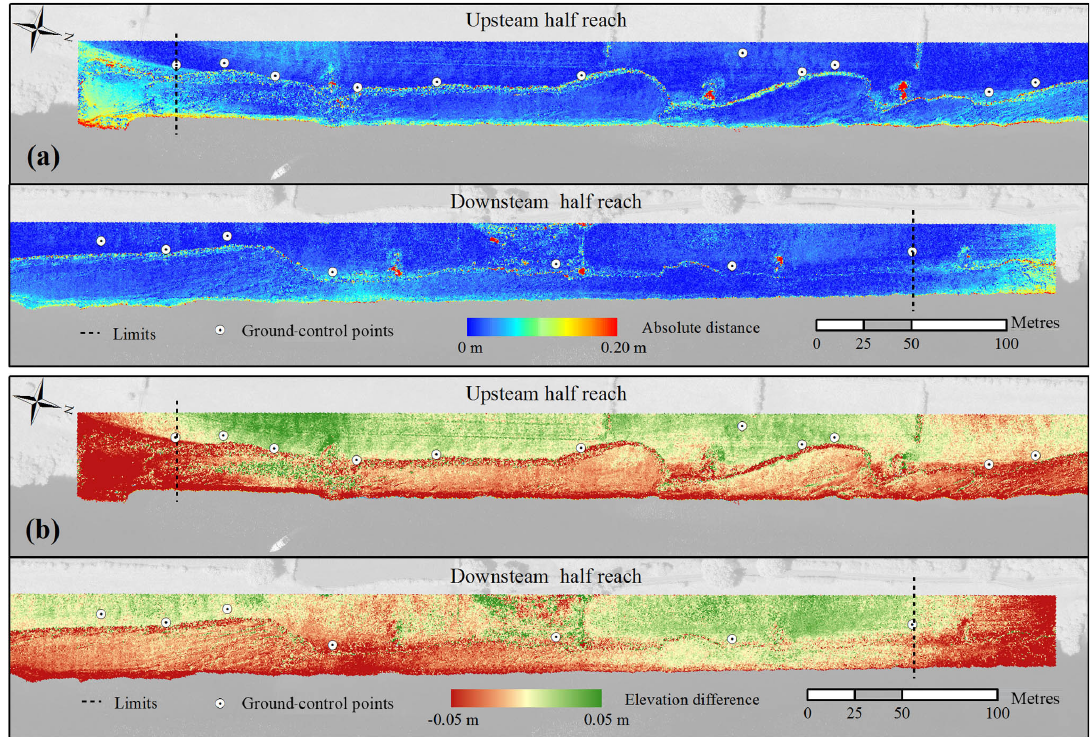
Figure 7. (a) Absolute elevation differences between SfM and ALS along the reach. (b) Signed elevation differences between SfM and ALS with a smaller scale range.